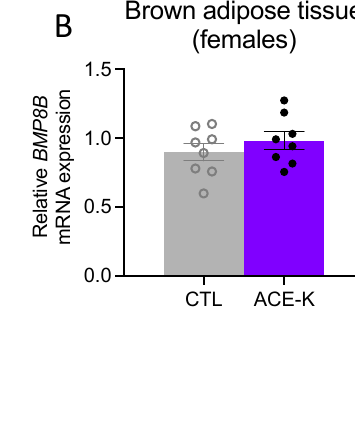
Figure 4. Effects of early life ACE-K consumption on adult brown adipose tissue (BAT) thermogenic markers. Early life ACE-K consumption at the ADI (15 mg/kg) decreased the relative mRNA expres- sion of BMP8B and UCP1 in male rats ( A , C ) relative to controls but had no effect in female rats ( B , D ). These effects were observed in the absence of differences in BAT percentage of total body weight for both sexes ( E , F ). Data are represented as mean ± SEM, ** p < 0.01, **** p < 0.0001; ACE-K: acesulfame potassium; CTL, control. 4. Discussion The effects of habitual sugar or LCS consumption during early life periods of devel- opment on subsequent energy balance control during adulthood is poorly understood.